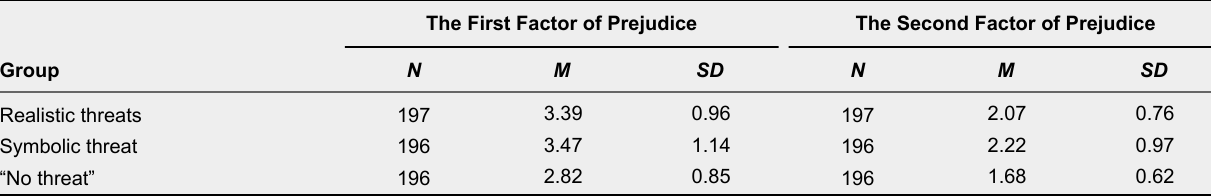
Means and Standard Deviations for Prejudice Toward Abirians